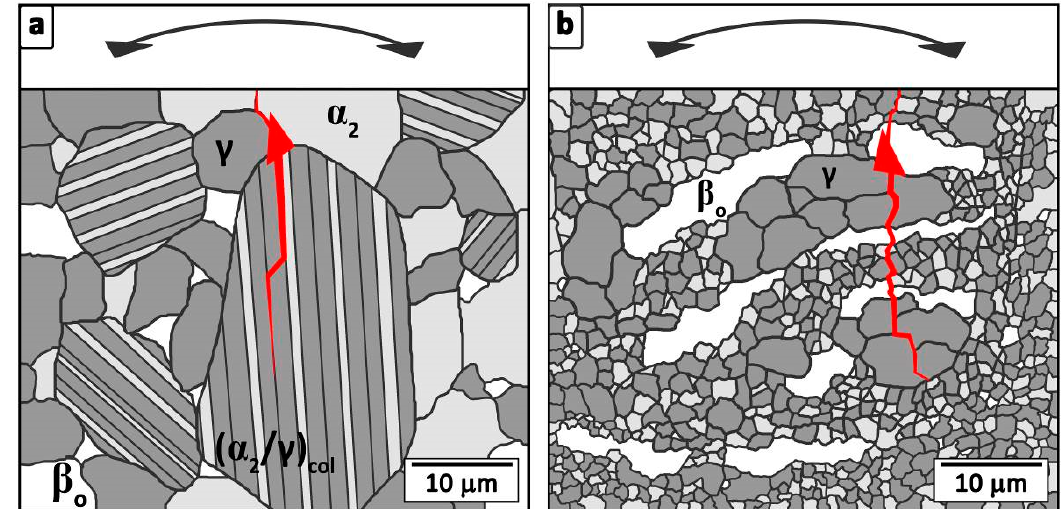
Figure 5. Schematic illustration of the two different predominant crack initiation and propagation modes. ( a ) Crack initiation (red triangle) at the interface between an α 2 - and γ -grain as well as the further crack growth within a cast/HIPed and heat treated microstructure. Subsequently, the crack splits a coarse ( α 2 / γ ) col , including inter- and translamellar propagation. ( b ) Crack growth within the hot-extruded material with a fine-grained microstructure. At RT, the crack initiation takes place below the specimen surface within the brittle elongated β o phase and propagates preferentially through the coarse γ grains.